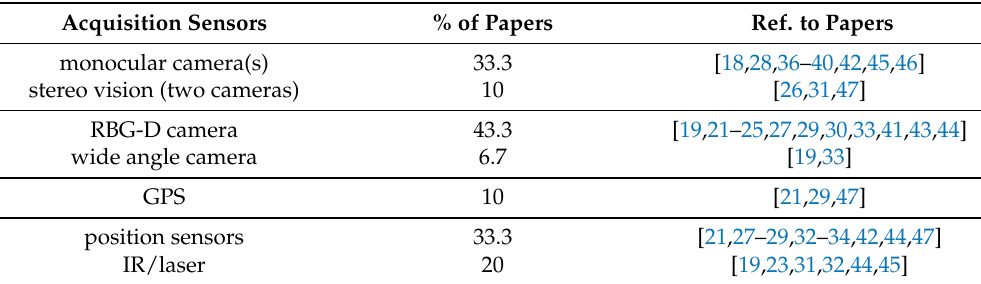
Table 2. Data-acquisition tools. By “position sensors”, we consider techniques and sensors such as inertial measurement units, odometry, or accelerometers/gyroscopes/magnetometers from a smartphone.